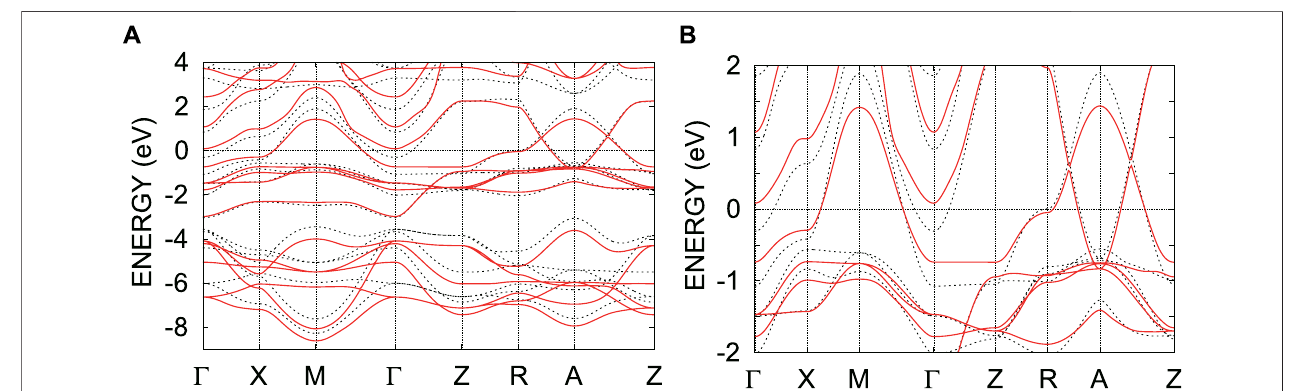
FIGURE4|(A) GWbandstructureforYNiO 2 and (B) itsmagni fi ed fi gure(solidlines).Forcomparison,thebandstructuresintheLDAisalsogiven(dottedlines).The zero energy corresponds to the Fermi